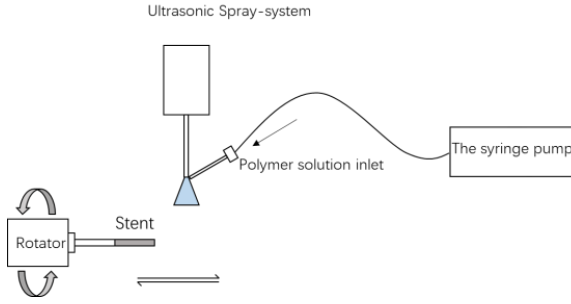
Figure 1. A schematic diagram for the preparation of the polymer coatings on stents.